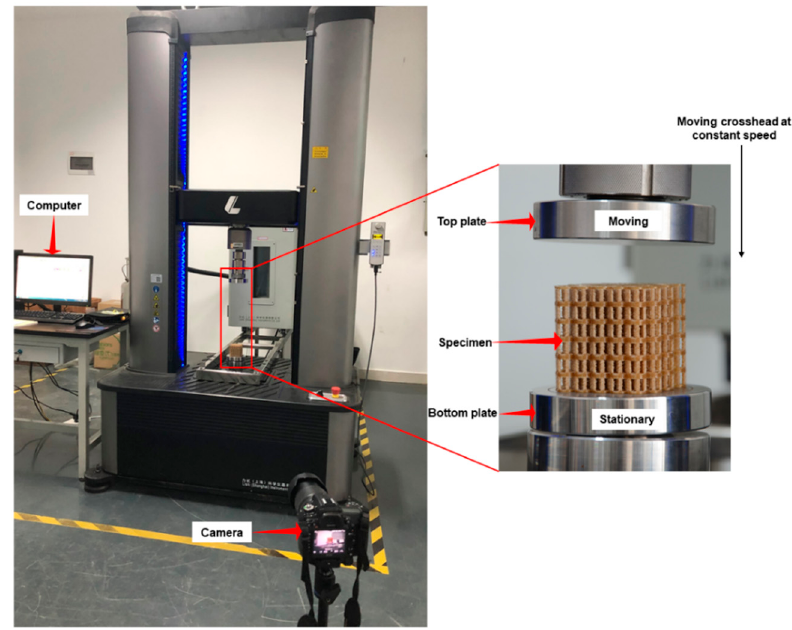
Figure 3. Experimental setup used for compression tests.